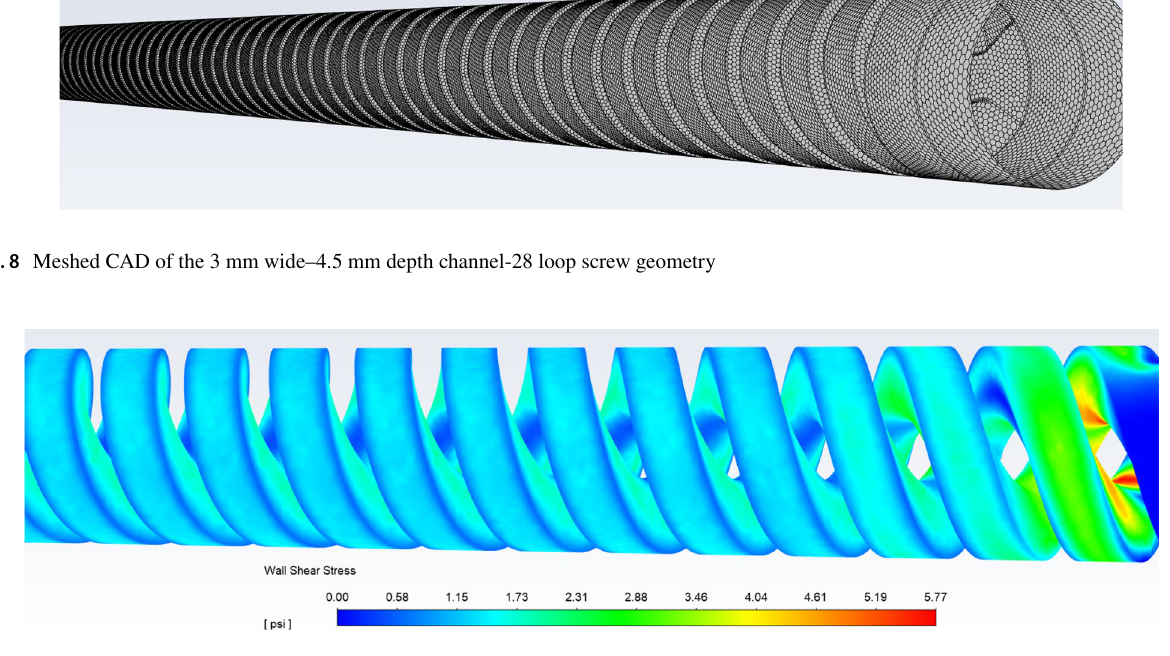
Fig. 9 Wall shear stress (psi) obtained in the CFD simulation of 3 mm wide–4.5 mm depth channel–28 loop screw with flow of 563 BPD and 1000 ppm of HPAM